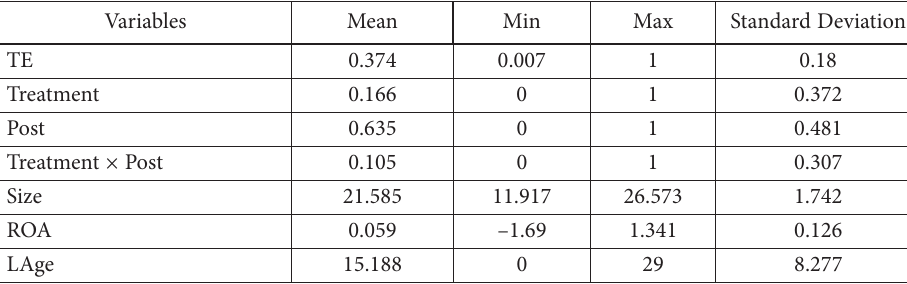
Table 3. Descriptive statistics – PSM sample (source: author’s calculation)